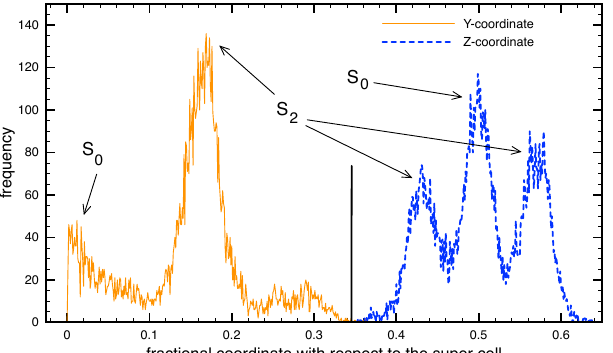
Figure 3. The histogram for the Σ 5 GB. The solid and dashed lines correspond to frequencies of occurrence of the H atom along the y - and z -coordinates, respectively. The x -coordinate is not shown because there is only one strong peak at 0.5 which corresponds to the GB located in the middle of the supercell. The coordinates are in fractional units of the first principles molecular dynamics simulation (FP-MD) supercell (corresponding to that in Figure 2 repeated three times along z ), and the positions S 0 and S 2 are defined in Figure 4.